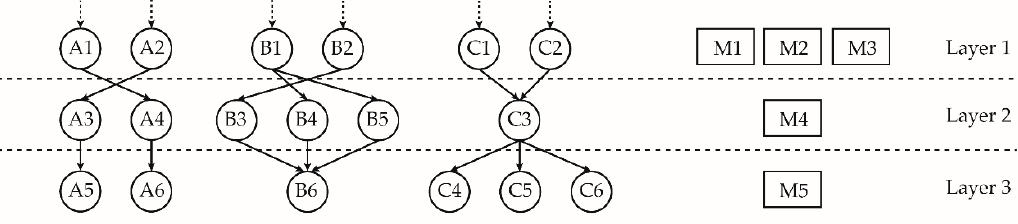
Table 2. Shared resources of each layer.